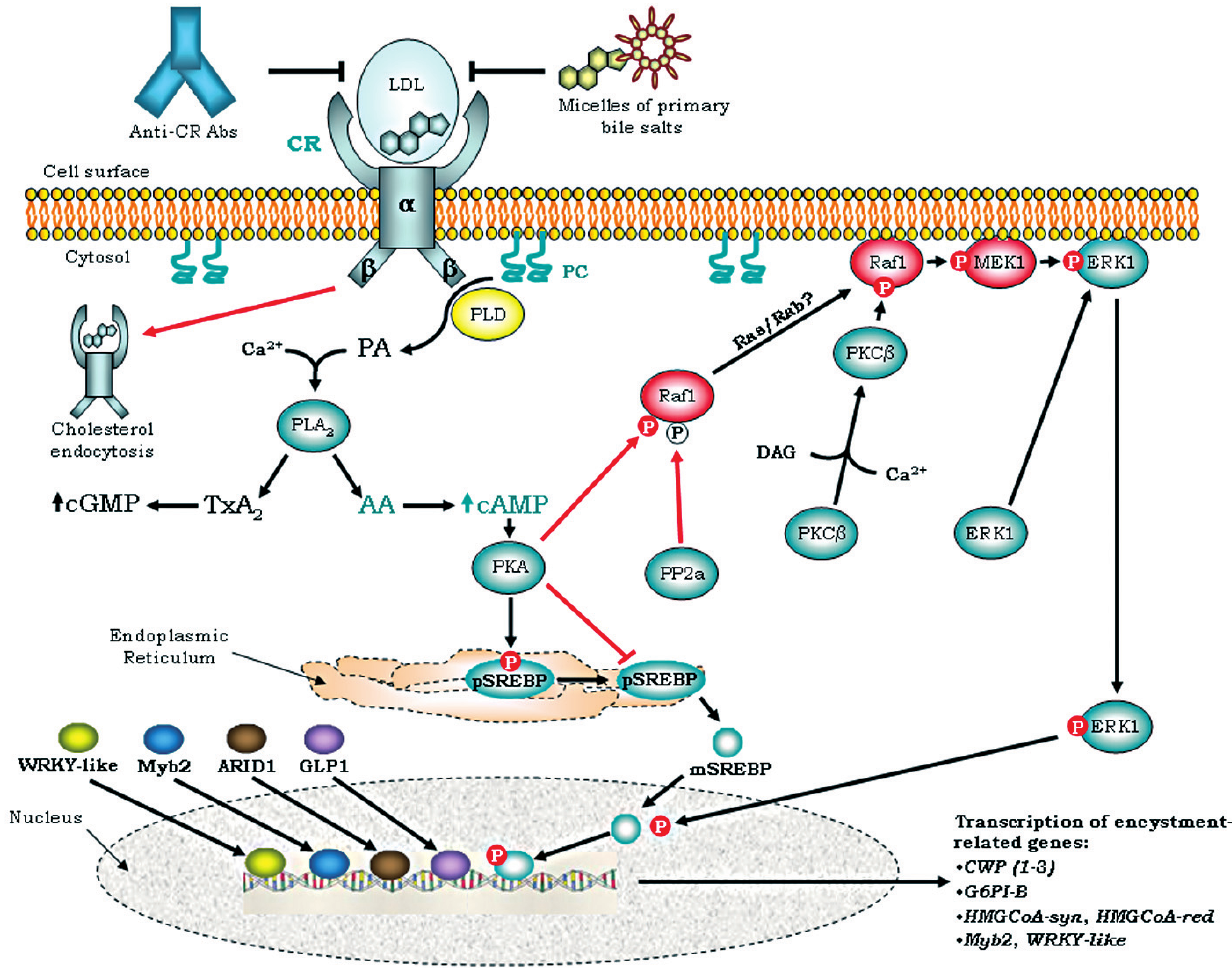
3. – Proposed signaling cascades of cholesterol-mediated gene transcription in G. duodenalis and their relation to encystation induc- tion. The giardial CR (that in mammalian cells consists of a 32 kDa-sized α subunit and two 19 kDa-sized β subunits) upon